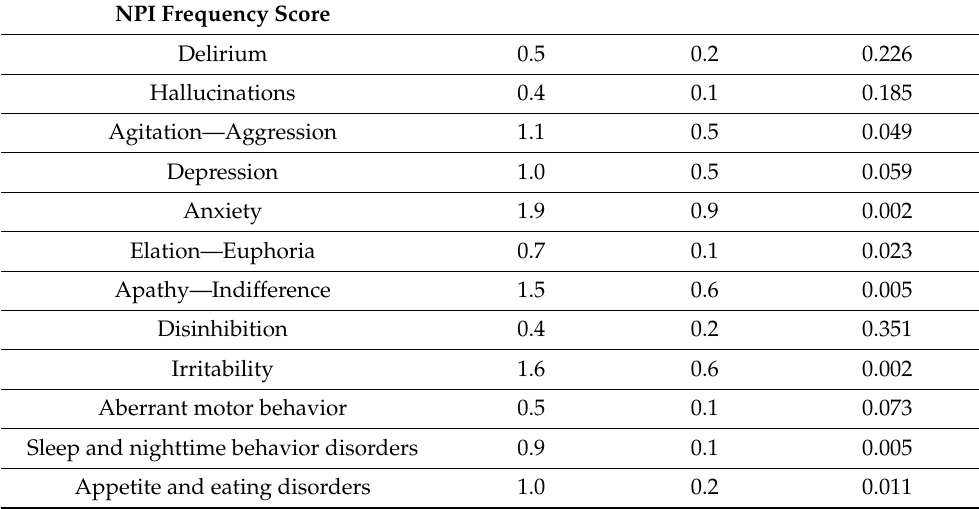
Table 5. Mindfulness- Patients: Evaluation of neuropsychiatric symptoms (T0–T1 six